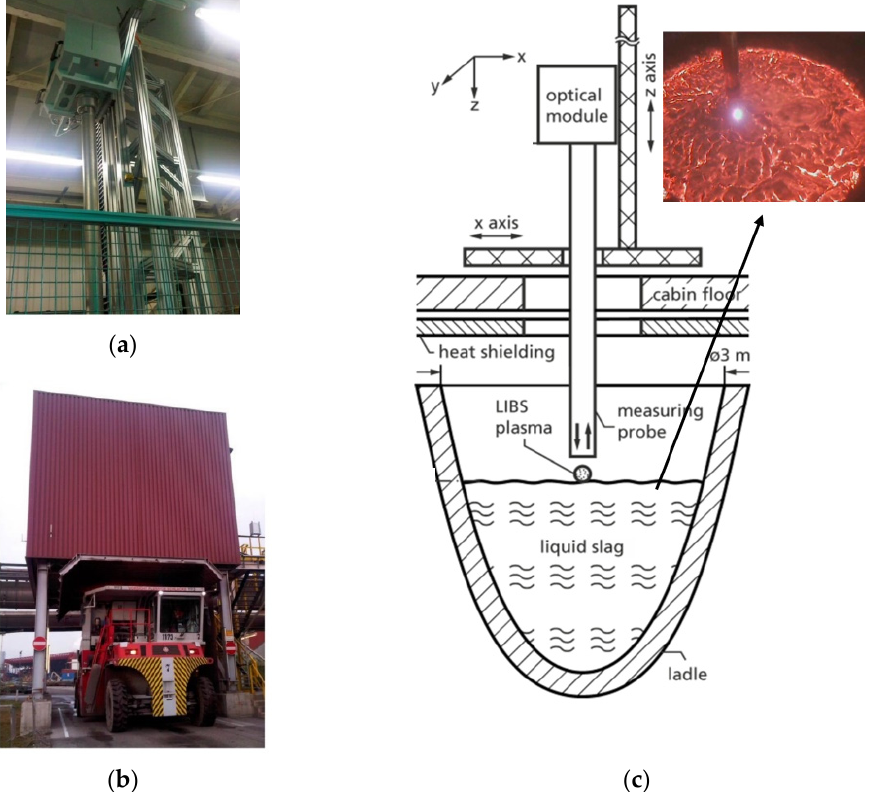
Figure 4. Schematic representation of system used by Sturm et al. [67]. ( a ) Measuring cabin consisting of aLIBS system, ( b ) slag transporter below the measuring cabin carrying ladle and ( c ) LIBS setup diagram (consist inset picture of camera view) reprinted (adapted) with permission from (Sturm, V., Fleige, R., de Kanter, M., Leitner, R., Pilz, K., Fischer, D., ... and Noll, R. (2014). Laser-induced breakdown spectroscopy for 24/7 automatic liquid slag analysis at a steel works . Analytical Chemistry, 86(19), 9687–9692). Copyright (2014) American Chemical